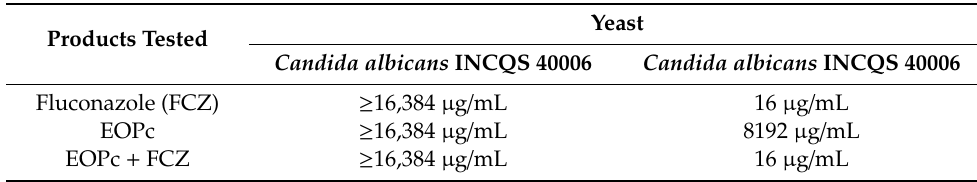
Table 3. Minimum fungicidal concentration (MFC) of essential oil of Piper caldense (EOPc) and fluconazole associated and isolated against strains of Candida albicans .